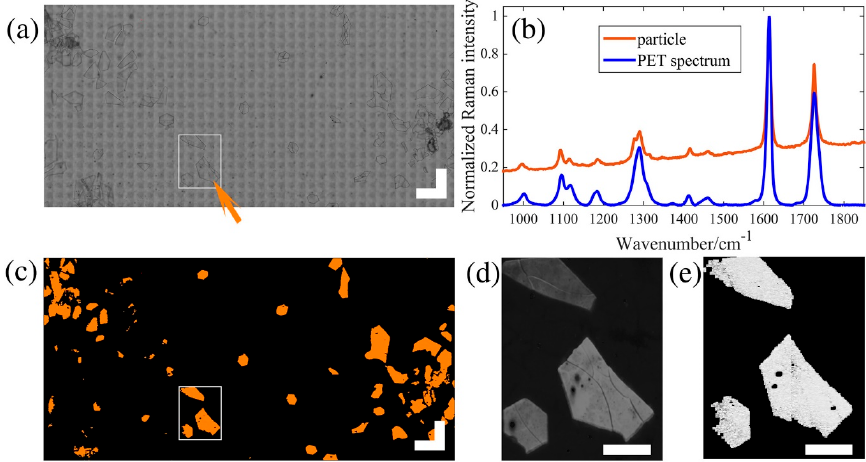
Figure 7. Stimulated Raman scattering (SRS) and Raman mapping of a nail polish extract. The tile scanned white light image of the measured area is shown in ( a ); scale bar: 500 μ m. A particle (indicated by the orange arrow) in this image was measured with conventional Raman for confirmation, and its spectrum is shown in ( b ); orange spectrum, particle). The blue curve is a Raman reference spectrum of polyethylene terephthalate (PET) for comparison. In the SRS overlay image ( c ), five binary versions of the five identification images were color coded and overlaid as follows: PET: orange; Nylon: red; polystyrene: green; and polypropylene and polyethylene were not found; scale bar: 500 µ m. ( d ) is a spontaneous Raman mapping from the area marked with a white square in ( a ) and ( c ), fitted with direct classical least squares to a reference spectrum of PET. ( e ) is the same area of the PET identified image with SRS, with greyscale values indicating the identification scores. Scale bars in ( d , e ): 200 µ m [56].